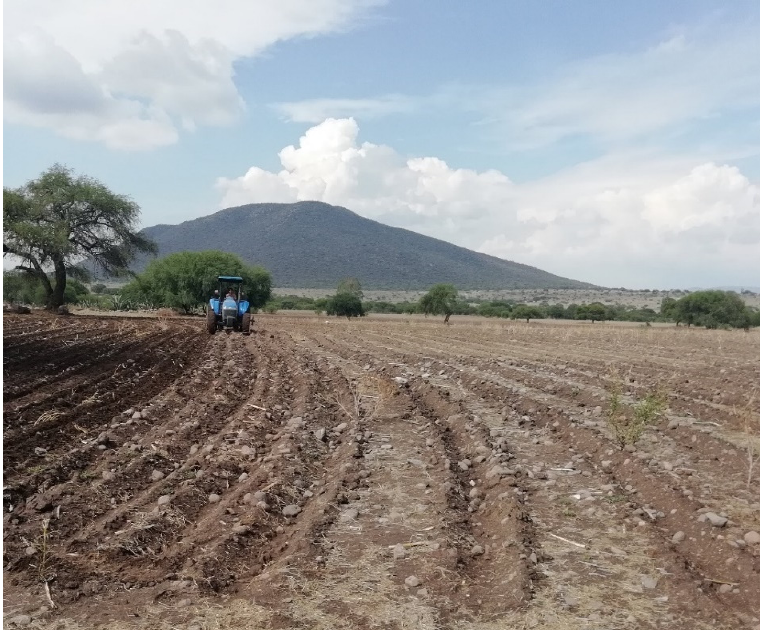
Figure 3. Sowing maize in broad and narrow permanent beds in San Juan del Río, Querétaro, under rainfed conditions. Table 3. Characteristics of the trials and evaluation period at each